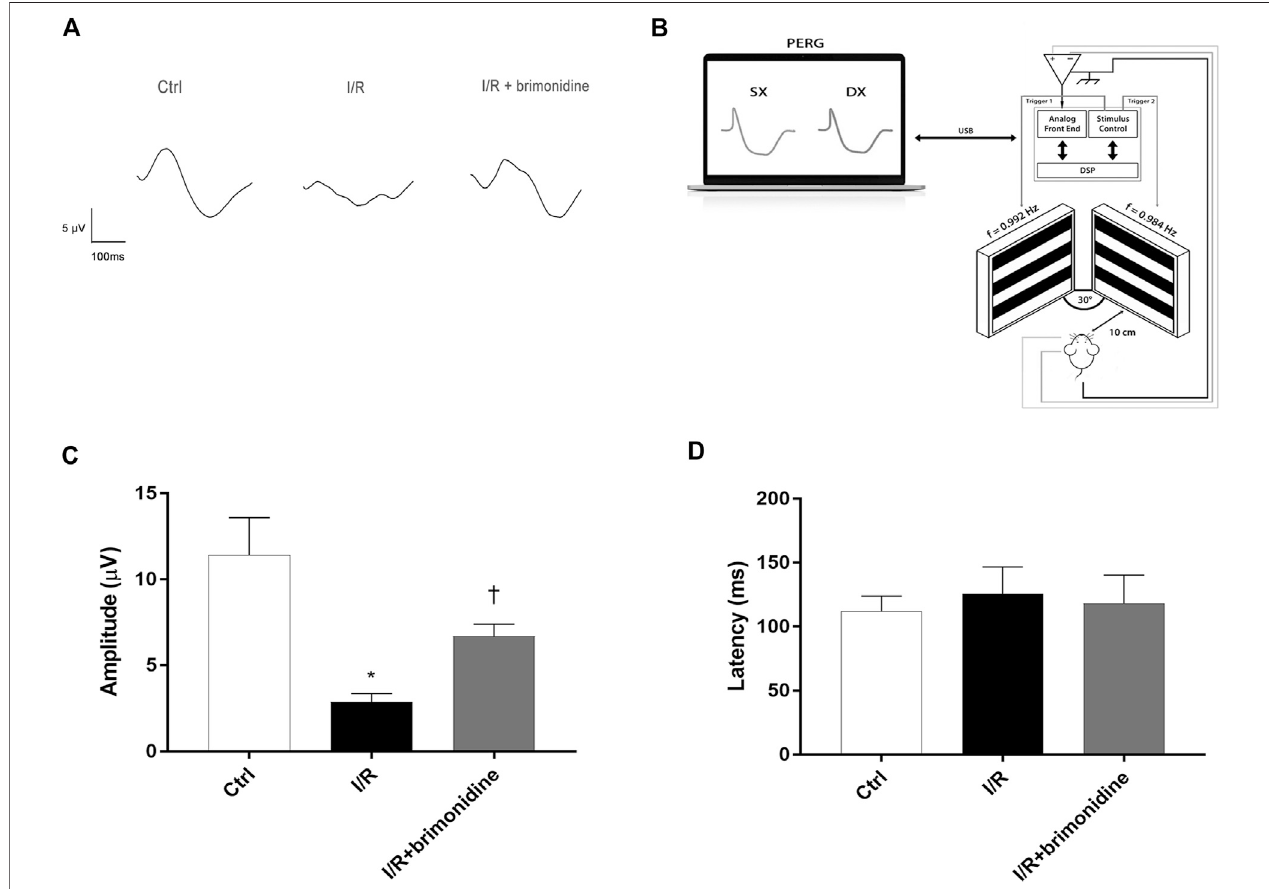
FIGURE1| RGCs function assessment. (A) RepresentativePERG waveformsinC57BL6/Jmice control,I/R and I/Rplus brimonidine. (B) Mouse PERGrecording layout. (C) Comparison betweenPERG amplitude values(µV) and latency values (D) of control, I/R and brimonidine treated mice. Brimonidinesigni fi cantly counteracted RCGsloss offunction induced byI/R injury, after 72 h, in mice retina. In each panel, bars representthemeanvalues and correspondingstandard errors ( ± SD).One-way ANOVA analysis was performed followed by the Tukey post-hoc test. * p < 0.05 vs. Ctrl; † p < 0.05 vs. I/R.